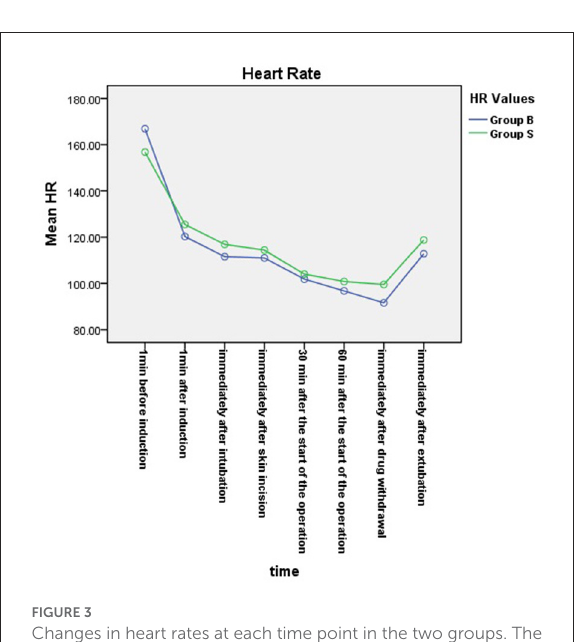
FIGURE3 Changes in heart rates at each time point in the two groups. The HR values significantly differed among the eight time points ( P < 0.05). There was no significantly difference in HR values between the two groups ( P > 0.05).